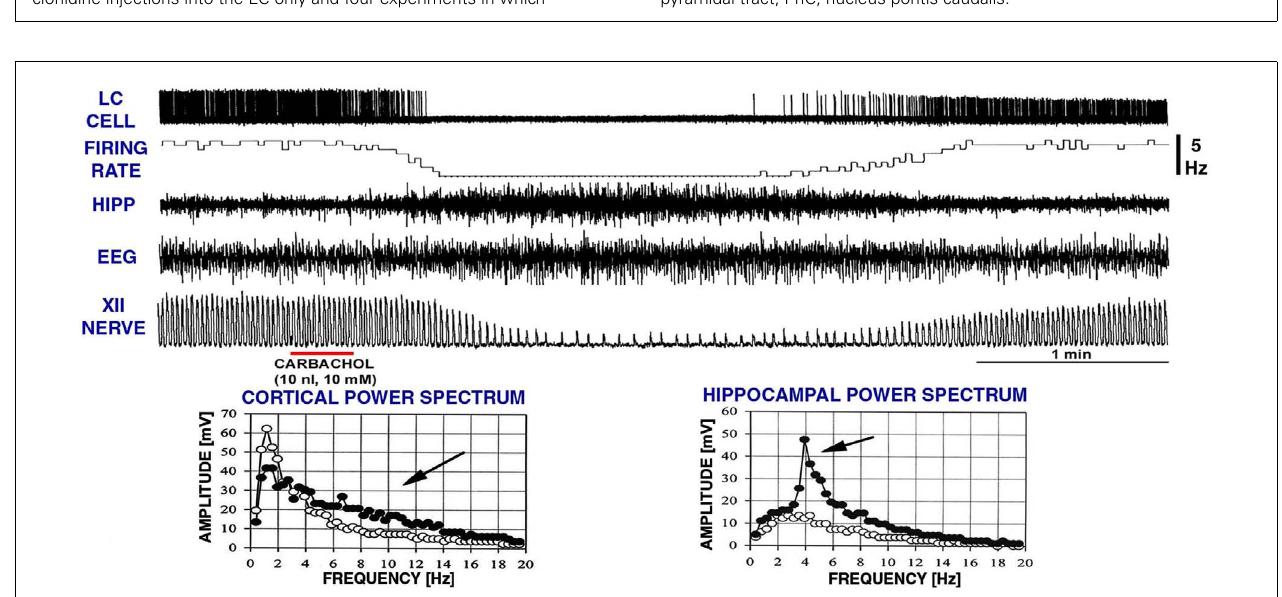
changes occur, noradrenergic LC cells stop firing.The episodes typically last 2–4min.The record was obtained in a related study (Fenik et al., 1999). XII nerve trace shows integrated activity of the XII nerve, with each upward deflection corresponding to the inspiratory phase of the central respiratory cycle.The power spectra were calculated for a 60-s period of activity prior to carbachol injection (open circles) and for a 60-s interval centered on the peak of the response to carbachol (filled circles). Arrows point to the parts of the spectra where differences can be noted between the control period and